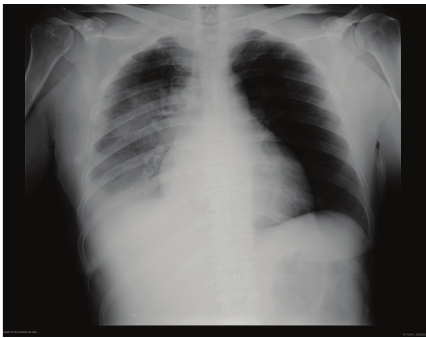
Figure 1: Admission chest radiograph showing patchy peri- bronchial and right lower lobe